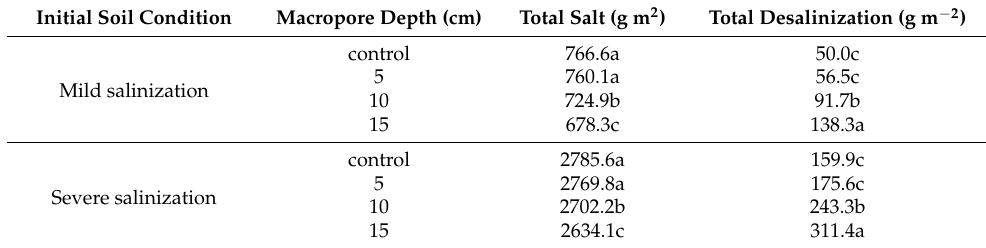
Figure 5. Mean soil salt content to the depth of 60 cm 25 days after irrigation under different macropore depth treatments for artificial macropores with sandy fillings (AMSF) method. ( a ) Initial soil condition of mild salinization; ( b ) initial soil condition of severe salinization. Control means soils without macropore. Mean values within same soil profile followed by different letters are significantly different ( p = 0.05). Table 3. Mean total salt and total desalinization in top 30 cm soil layer after 25 days of irrigation for different macropore depth treatments for artificial macropores with sandy fillings (AMSF) method. Control means soils without macropore. Mean Values within a column followed by different letters are significantly different ( p =